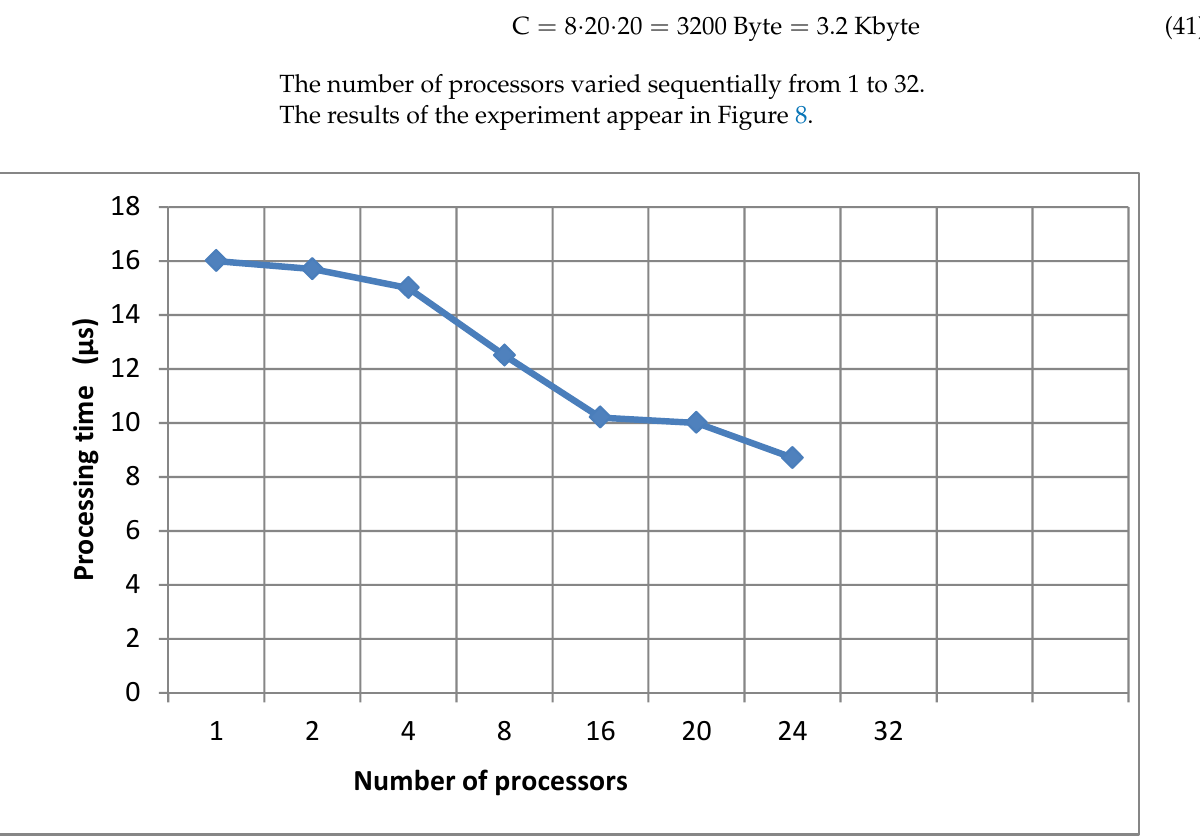
Figure 9. Dependence of SVD processing time on the number of computing processors at a matrix size of 200 × 200. 3.